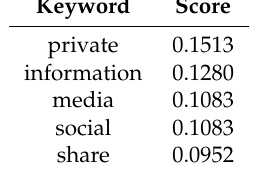
Table 8. Top words used to define visual privacy using TF-IDF Scores for each document.